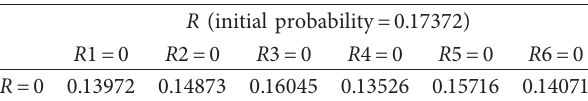
Figure 8: Sensitivity analysis of “technology resource risk ( R 6).” (a) R 6 � “yes” state. (b) R 6 � “no” state. Table 10: Risk reassessment results of R